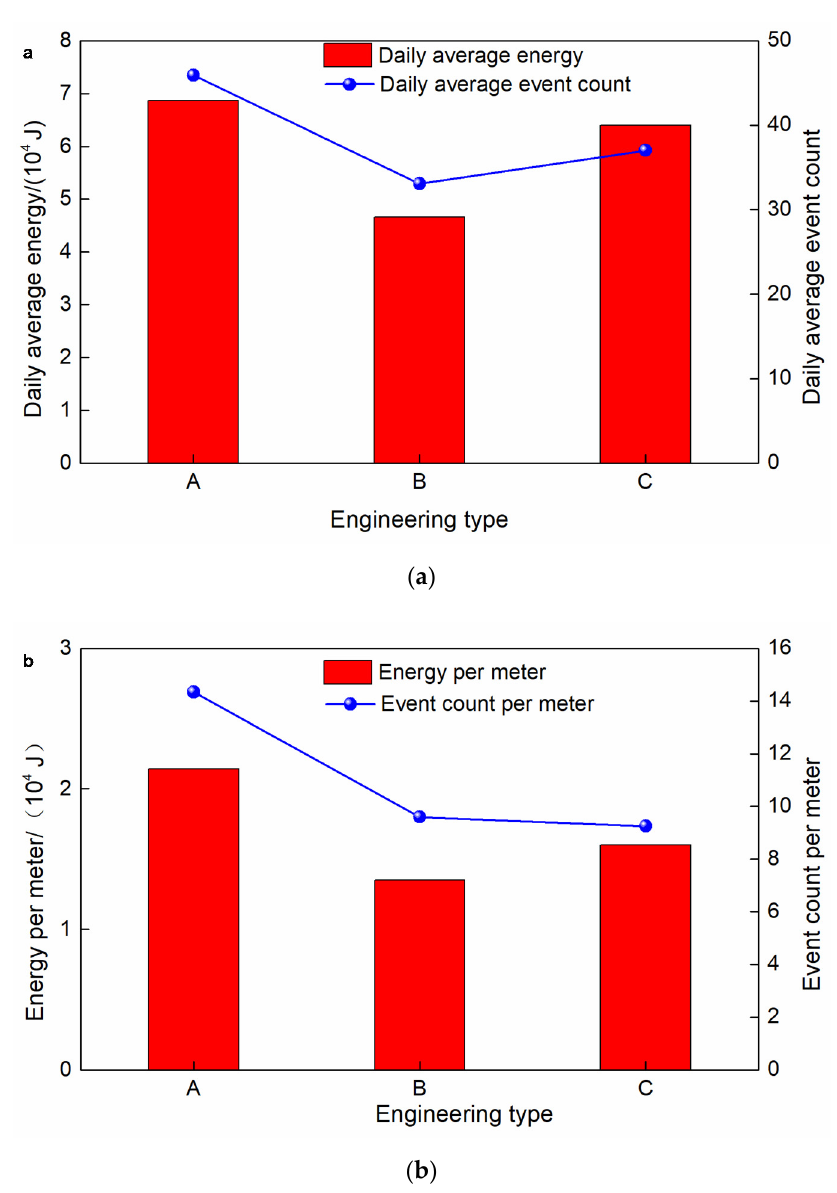
Figure 18. Pressure relief effectiveness of different pressure relief projects: ( a ) the daily average energy and event count and ( b ) the average energy per meter and event count per meter.